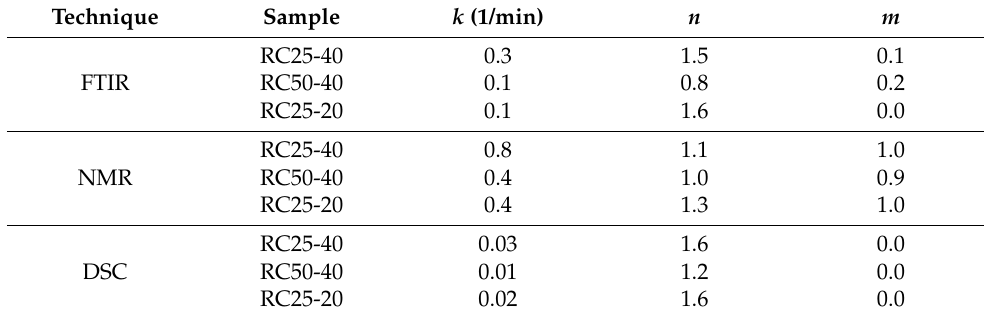
Table 1. Kinetic parameters based on different